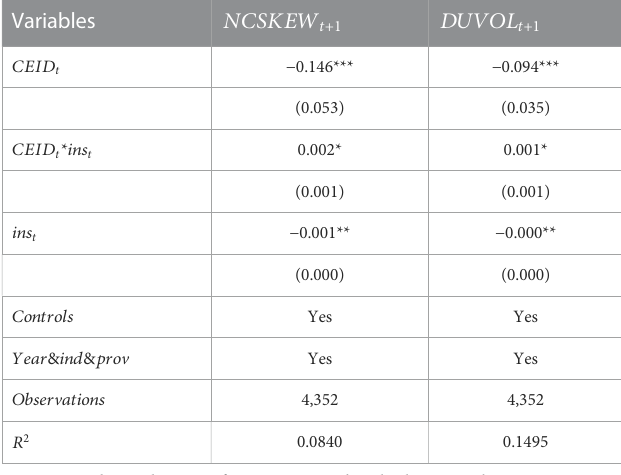
TABLE 10 Analysis based on the perspective of institutional investors ’ shareholding